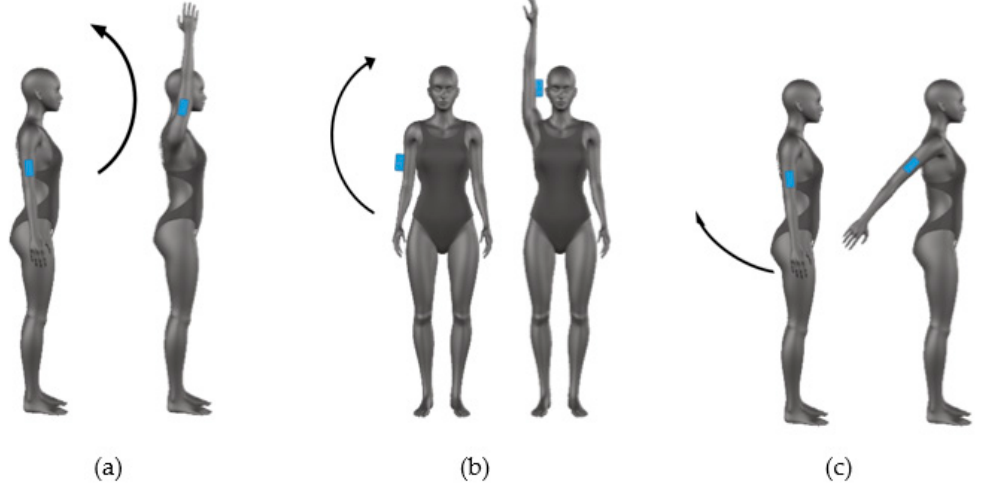
Figure 1. Mobility of shoulder: sensor positioning and movement direction for the flexion ( a ), abduction ( b ), and extension ( c ) task.